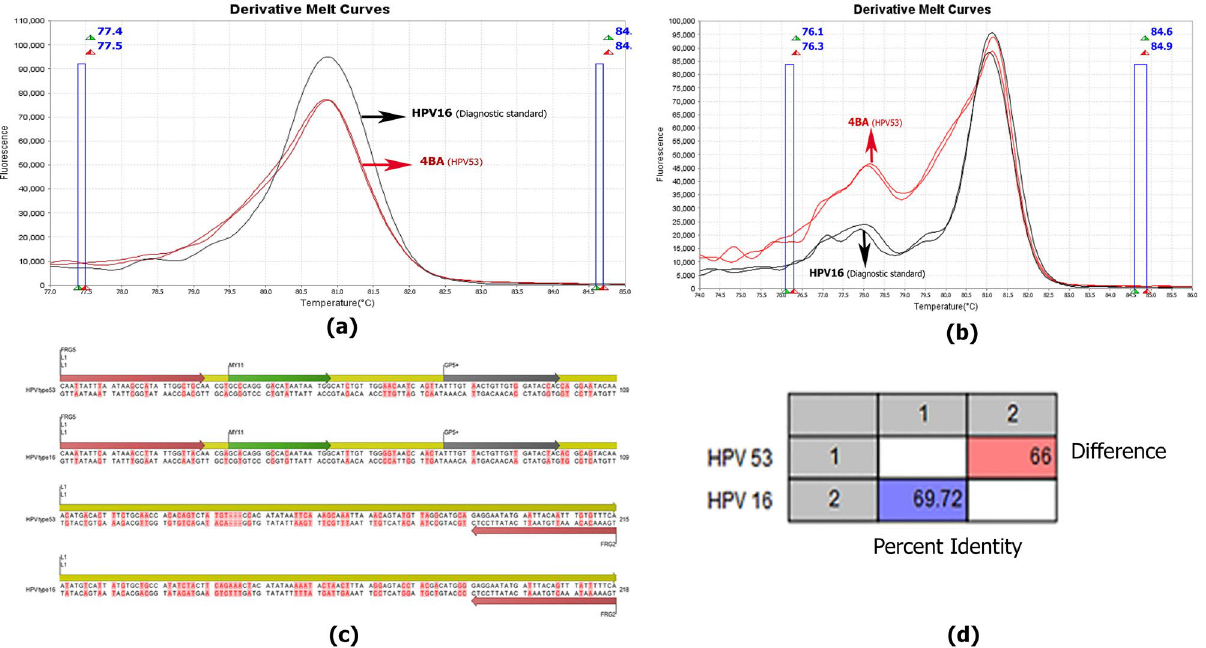
Figure 3. Derivative melt curve released of approach one, related to HPV 16 as a diagnostic standard and isolate 4BA as microarray-identification HPV 53 ( a ). Derivative melt curve released of approach two, related to HPV 16 as a diagnostic standard and isolate 4BA as microarray-identification HPV 53 ( b ). Schematic map of the amplification region of human papillomaviruses 16 and 53 in this study and the location of the primers using CLC workbench 12 software ( c ). Pairwise comparison of the amplified region in approach one related to HPV 16 (diagnostic standard) and isolate 4BA (HPV 53) using CLC workbench 12 software ( d ).